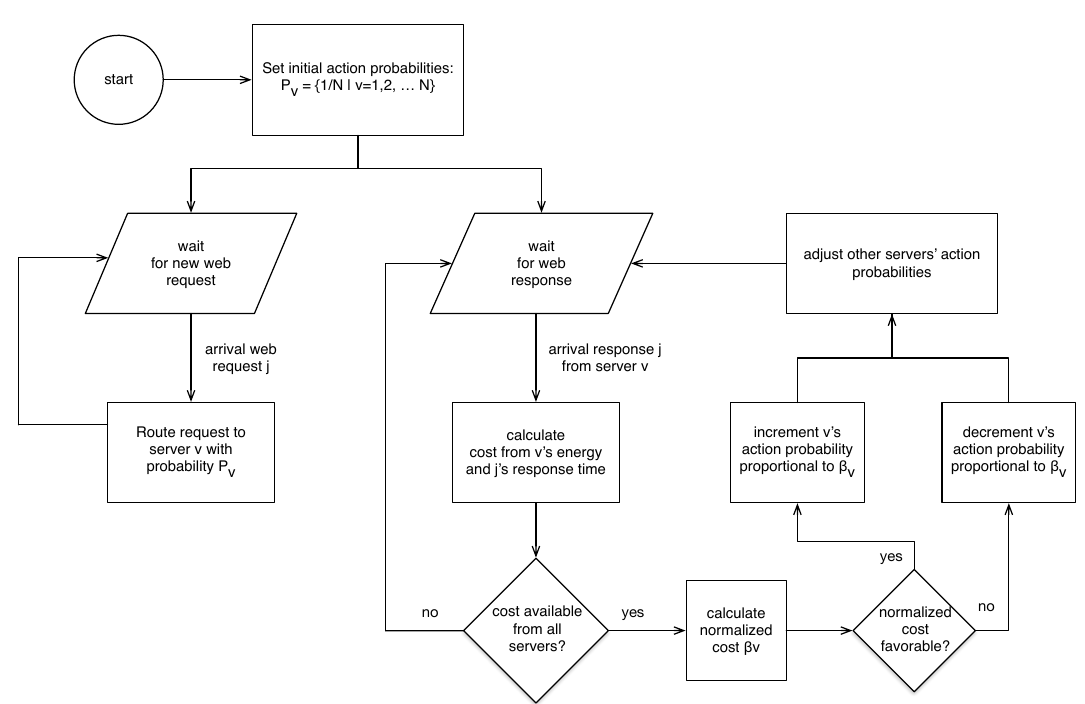
Figure 2. Flow chart of the proposed algorithm for dynamic web request routing with the Cost-Aware S-Model Reward Penalty Epsilon (CA-S)